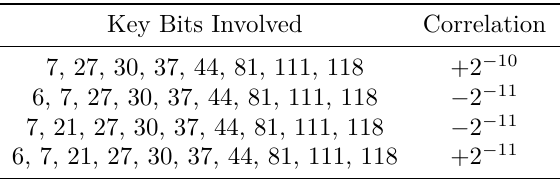
Table 4: Linear trails for 256-Round P b of TinyJAMBU, where the input mask involves bits 7, 30, 37, 44, 54, 64, 77, 81, 84, 91, 98, 118, and 121, and the output mask involves bit